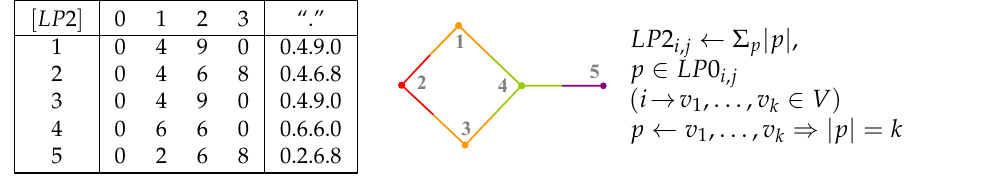
Figure 18. [ LP 2 ] on Figure 1.